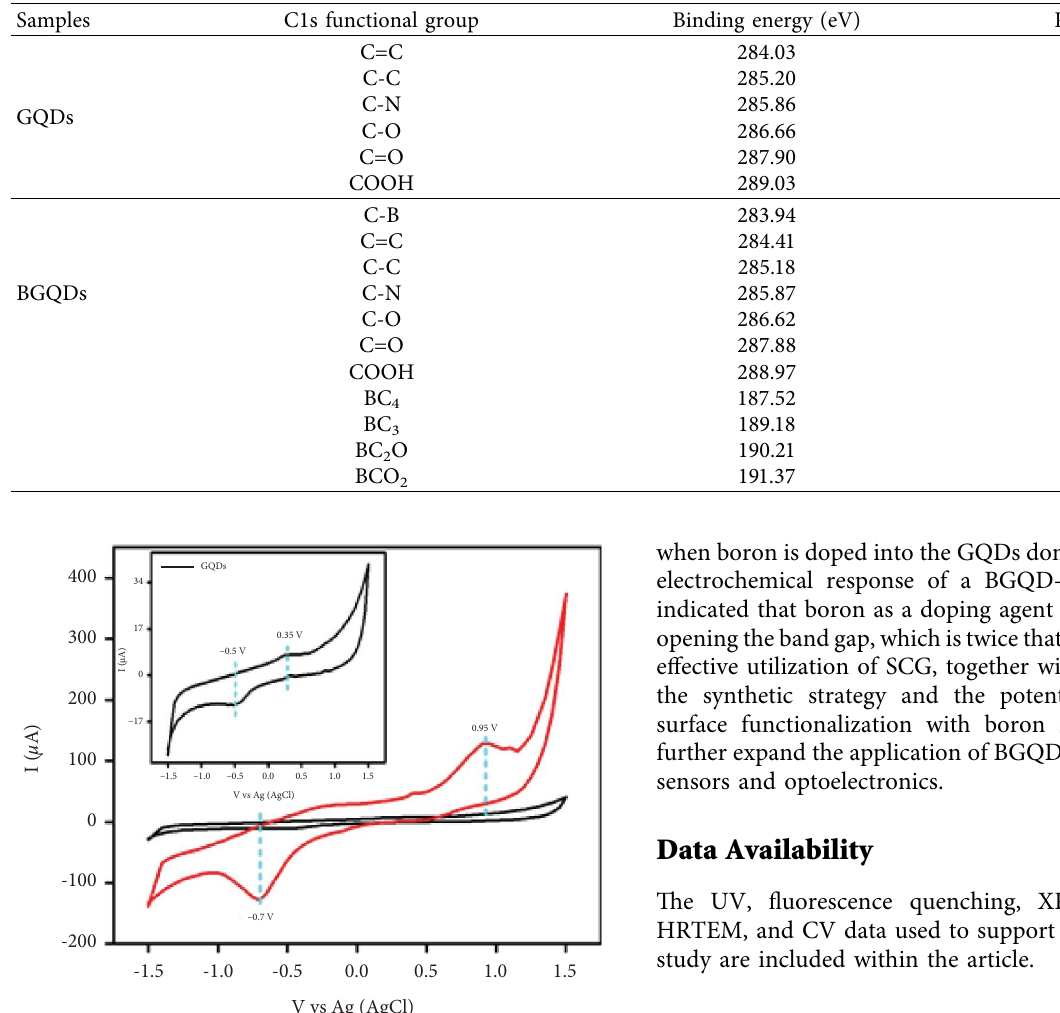
Table 1: Summary of C1s core level XPS spectra of GQDs and